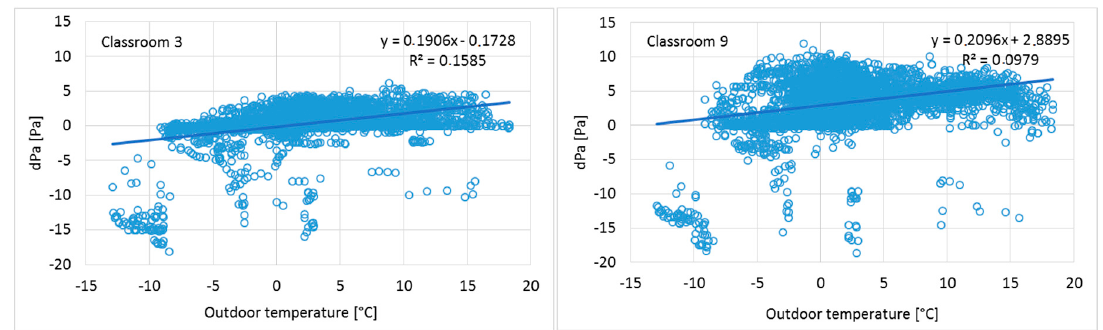
Figure 5. Relation between outdoor temperature and pressure difference across the envelope in Classrooms 3 and 9 with air handling unit without density-corrected airflow rates.